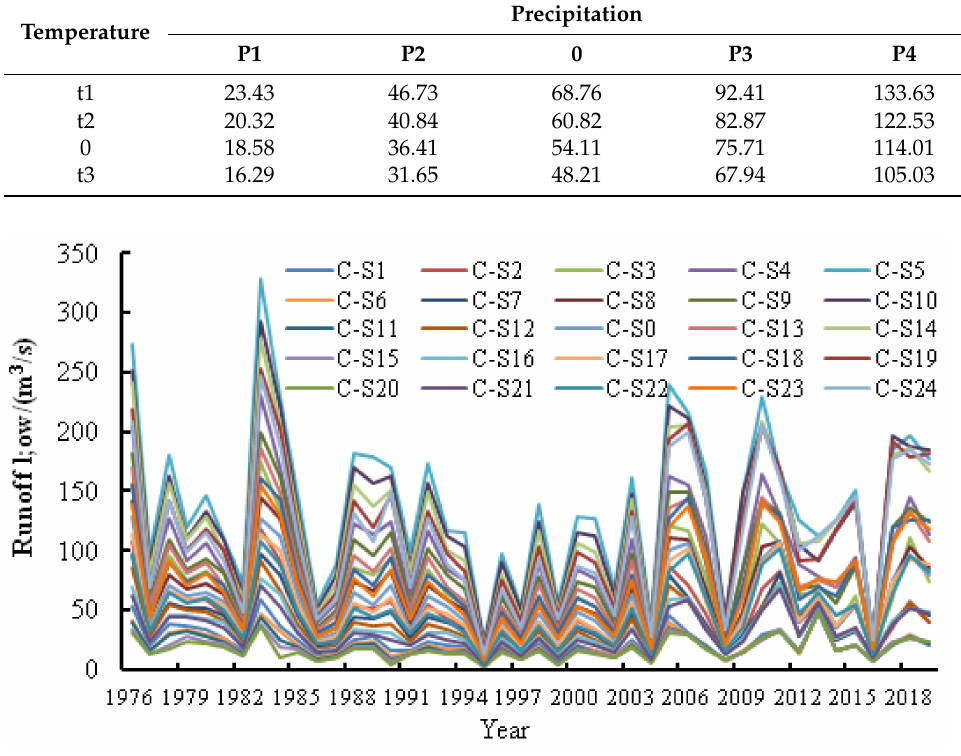
Figure 13. Variation trend of annual simulated runoff under different climate scenarios. Table 7 showed the simulation results of monthly runoff under the climate